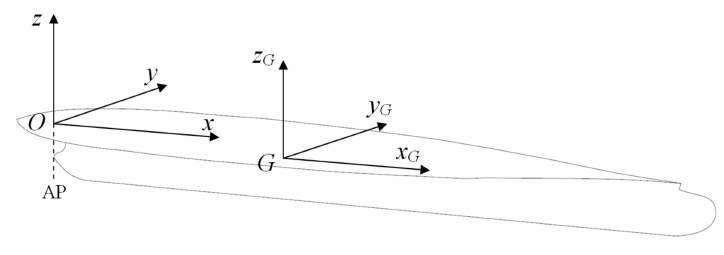
Figure 1. Ship coordinate